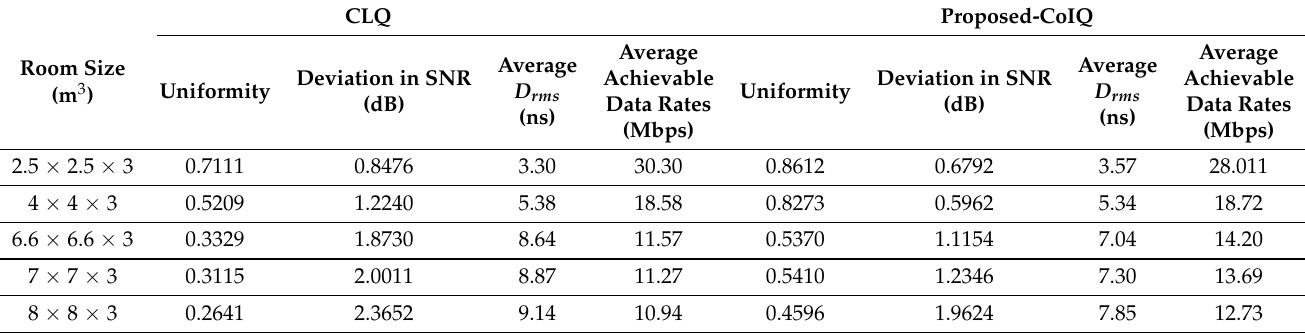
Table 5. Downlink performance of CoIQ and CLQ for different room